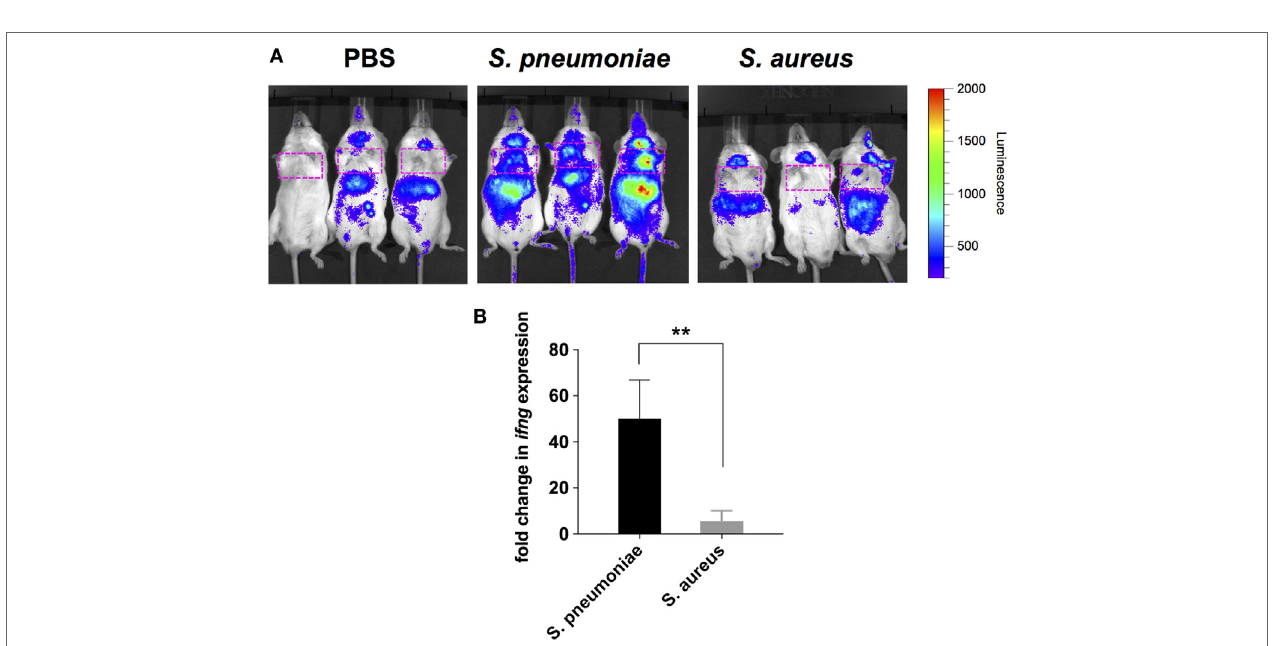
FigUre 5 | Induction of IFN- β and IFN- γ gene expression in infected mice. (a) Luciferase gene expression in Δβ -luc reporter mice infected with Streptococcus pneumoniae (middle panel), Staphylococcus aureus (right panel), or treated with PBS (left panel) at 12 h post-inoculation. Mice were injected with luciferin (i.p.) and luciferase activity was visualized immediately in the IVIS 200 imaging system. The intensity of emission is represented as a pseudocolor image. The red box indicates the anatomical location of the lungs. (B) Quantification of IFN- γ gene expression in the lungs of S. pneumoniae- infected (black bar) or S. aureus- infected (gray bar) mice at 12 h post-inoculation by real-time PCR. Values are expressed as the fold change between the expression of infg in infected mice and the expression of this gene in uninfected control mice. Each bar represents the mean ± SD of three independent experiments. ** p < 0.01.